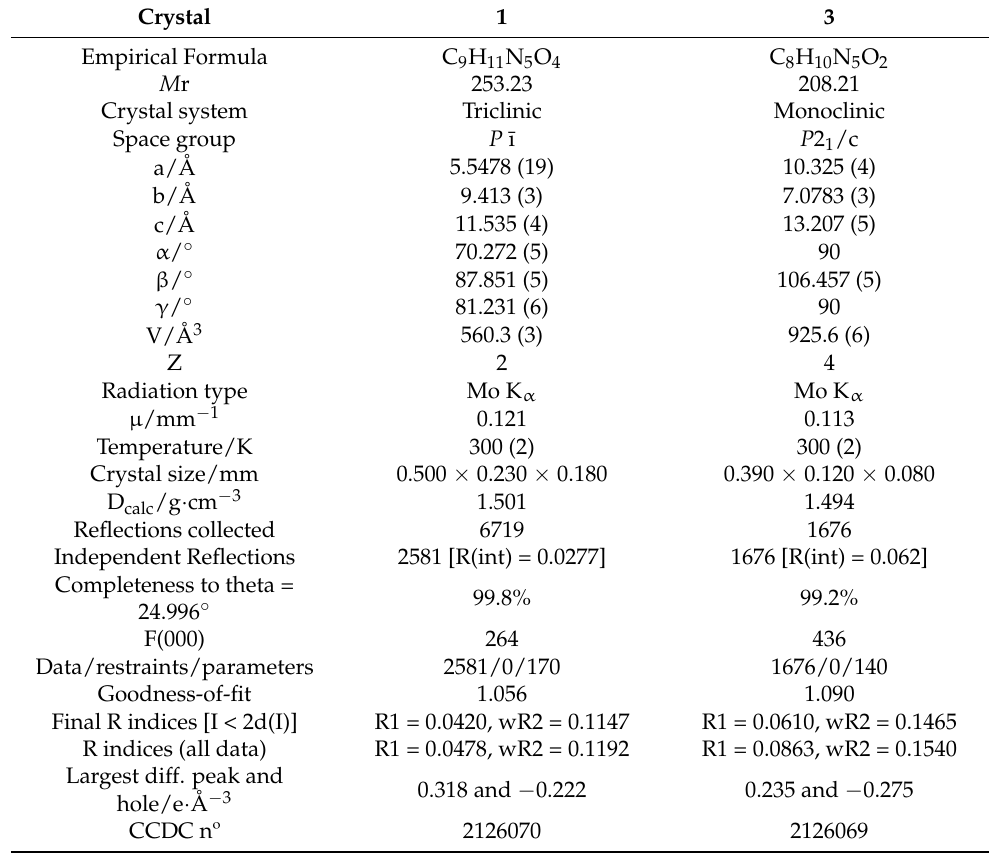
Table 1. Crystallographic data and refinement for salts 1 and 3